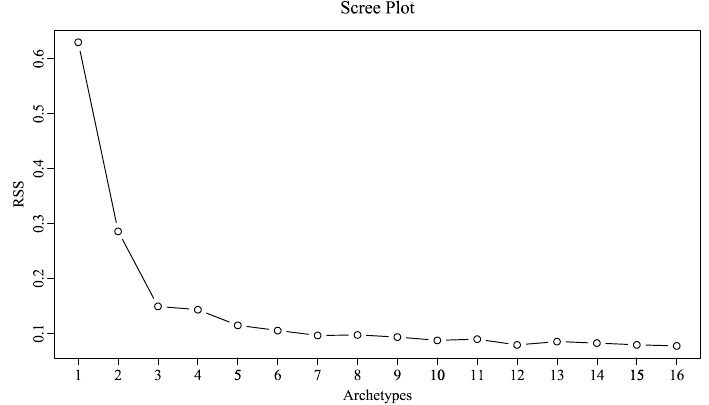
Figure 2. Scree plot of the result from AA. The maximum number of archetypes is initially set as 16 and eight chains were set to run to obtain a global optimum. We used the non-interference-based “elbow criterion” on the RSS curve to select the appropriate number of archetypes.